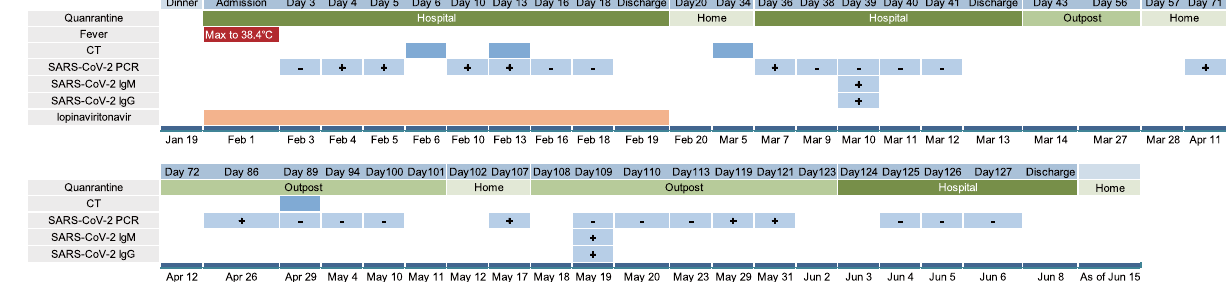
Figure 2: Timeline of this case after